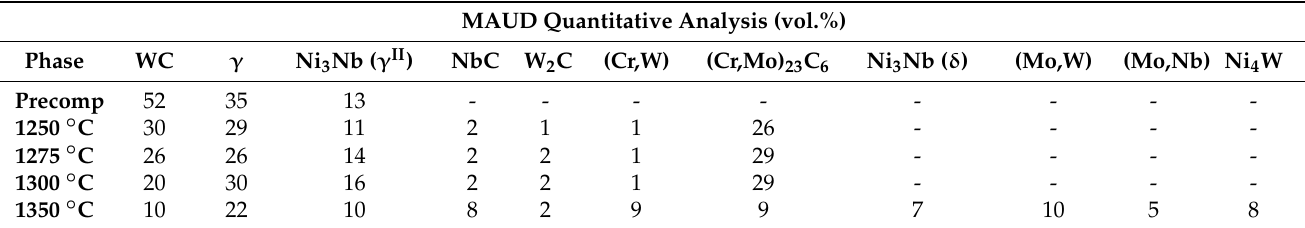
Table 2. Quantitative analysis obtained by MAUD of the phases present in different conditions. MAUD Quantitative Analysis (vol.%)